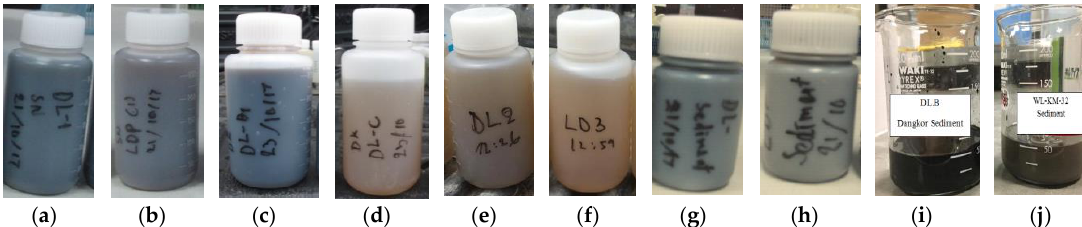
Figure 3. Leachate ( a , b ) Nonthaburi, DL and LDP; ( c , d ) Dangkor, DL.B and DL.C; ( e , f ) KM-32, DL and WL, and sediment ( g , h ) Nonthaburi, DL and LDP; ( i ) Dangkor, DL.B; ( j ) KM-32, WL.